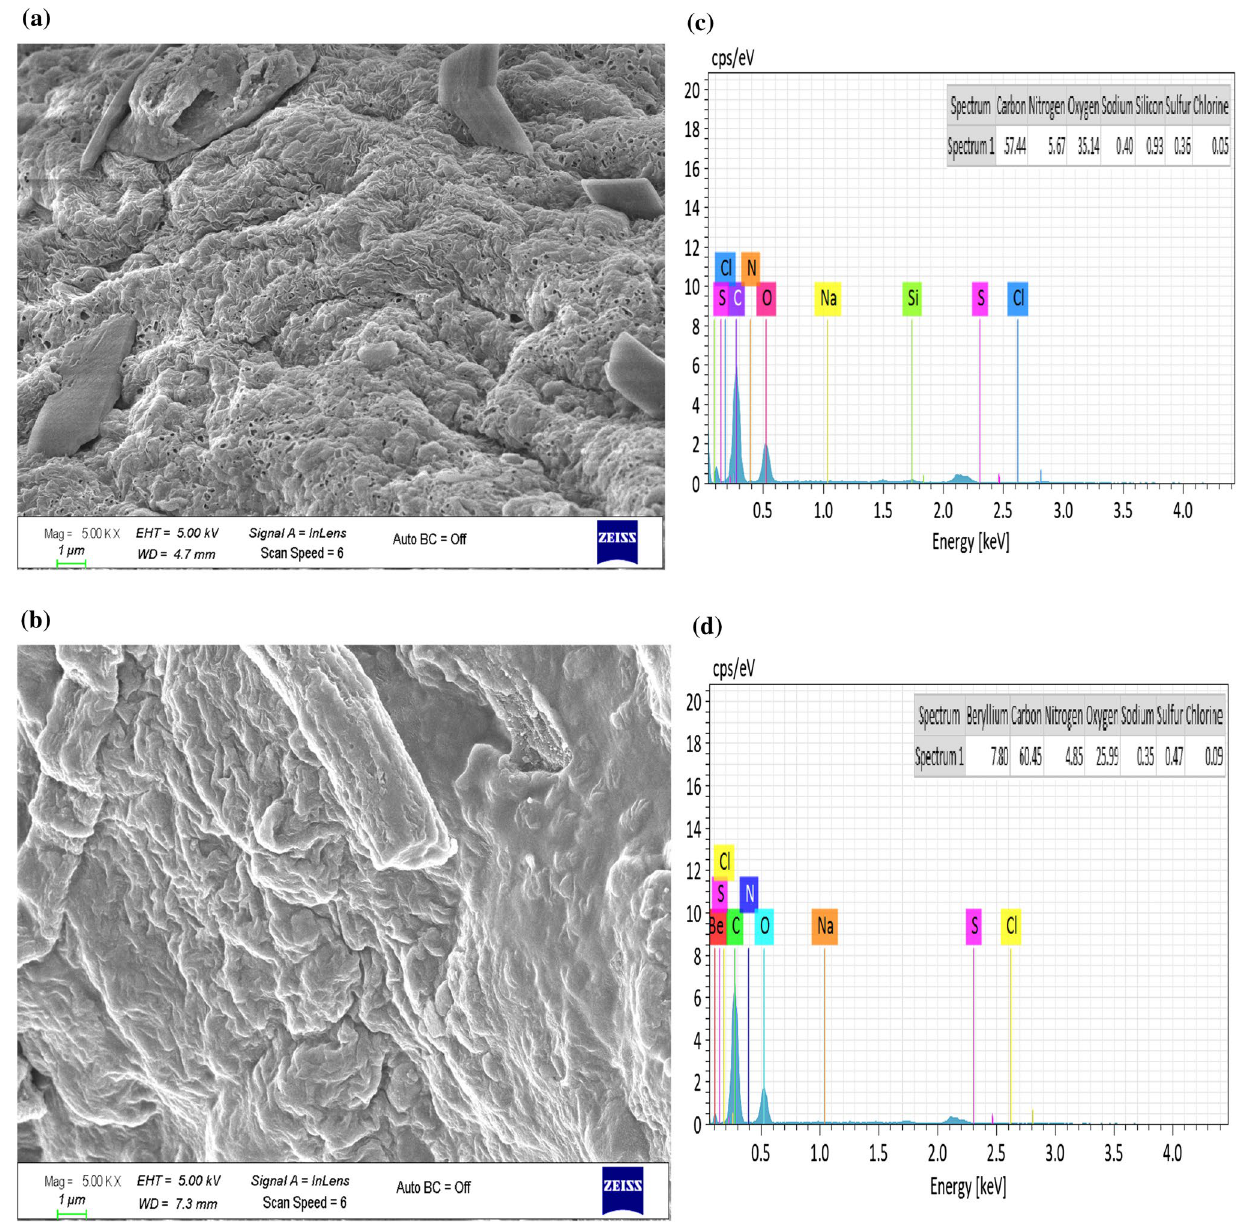
Fig. 4 SEM images of LPF ( a before and b after biosorption of MB) and EDX results ( c before and d after biosorption of